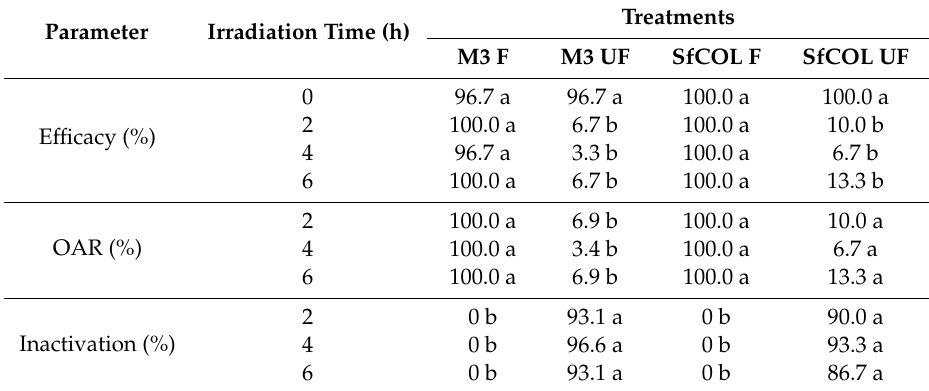
Table 4. Susceptibility of unformulated and formulated mixture M3 to ultraviolet